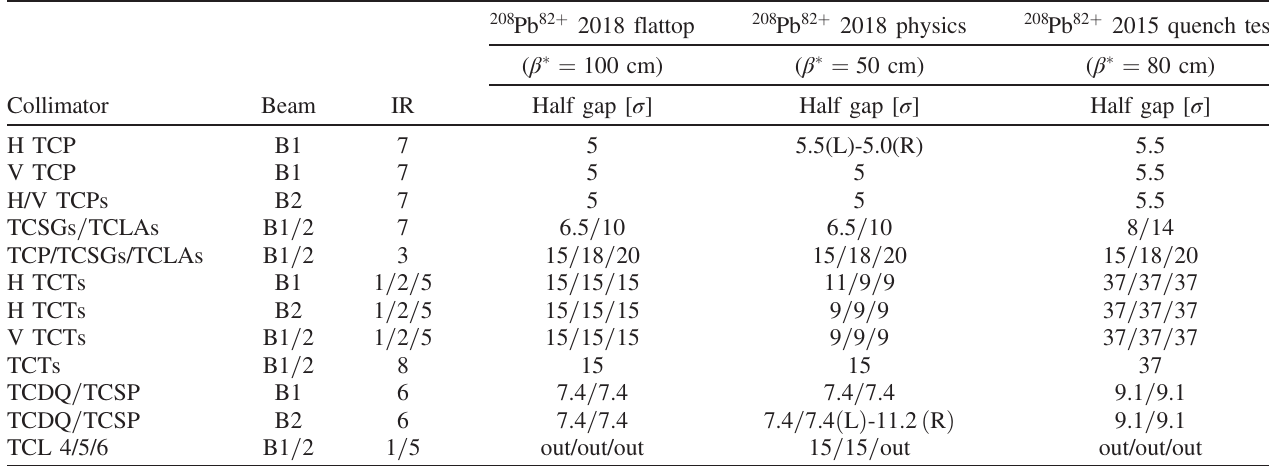
TABLE II. 2015 and 2018 208 Pb 82 þ ion runs collimator settings for ϵ P H and V correspond to horizontal and vertical planes,